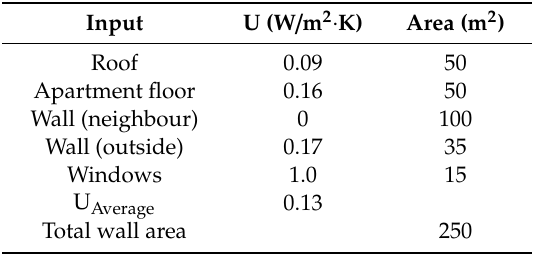
Table 1. House size and insulation data [24].